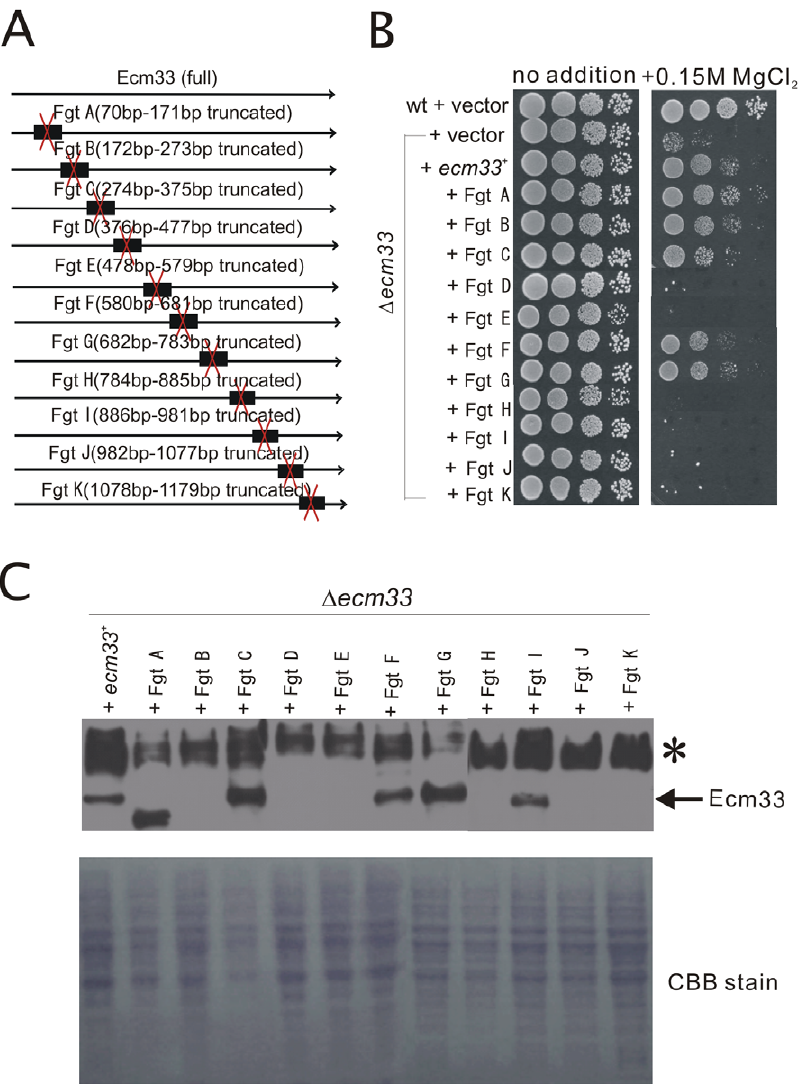
Figure 3. Deletion analysis of the ecm33 + . (A) Structural features of the truncated mutants of Ecm33. (B) The D ecm33 mutant phenotype suppression by Ecm33 truncated mutants. Cells transformed with the multicopy vector or vector containing various truncated genes were spotted onto each plate as indicated and incubated for 4 days at 30 u C. (C) Protein levels of Ecm33 examined by immunoblot analysis. The ecm33 deletion cells were transformed with the ecm33 + , or truncated ecm33 + gene were grown to mid-log phase in EMM at 30 u C. Cells were washed and incubated for 24 h and then analyzed by immunoblotting using anti-Ecm33 monoclonal antibody as described under ‘‘Materials and Methods.’’ The panel indicated as CBB stain shows the CBB staining of the same gel to show the presence of equal amount of proteins in each